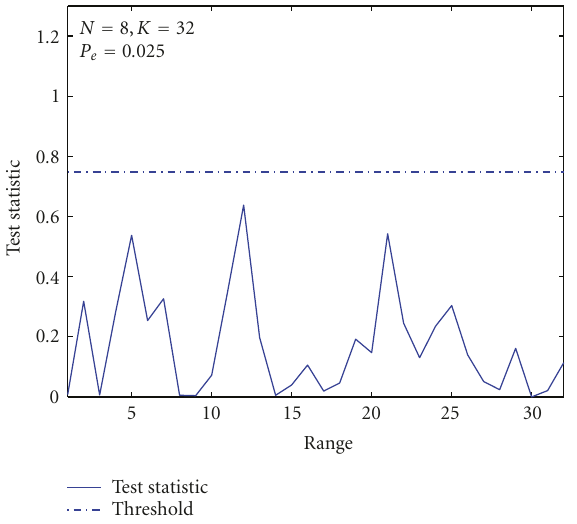
Figure 5: Theoretical and bootstrap CDF of the test statistic in homogeneous K -distributed clutter, where ν = 0 . 5, μ = 1, and B =